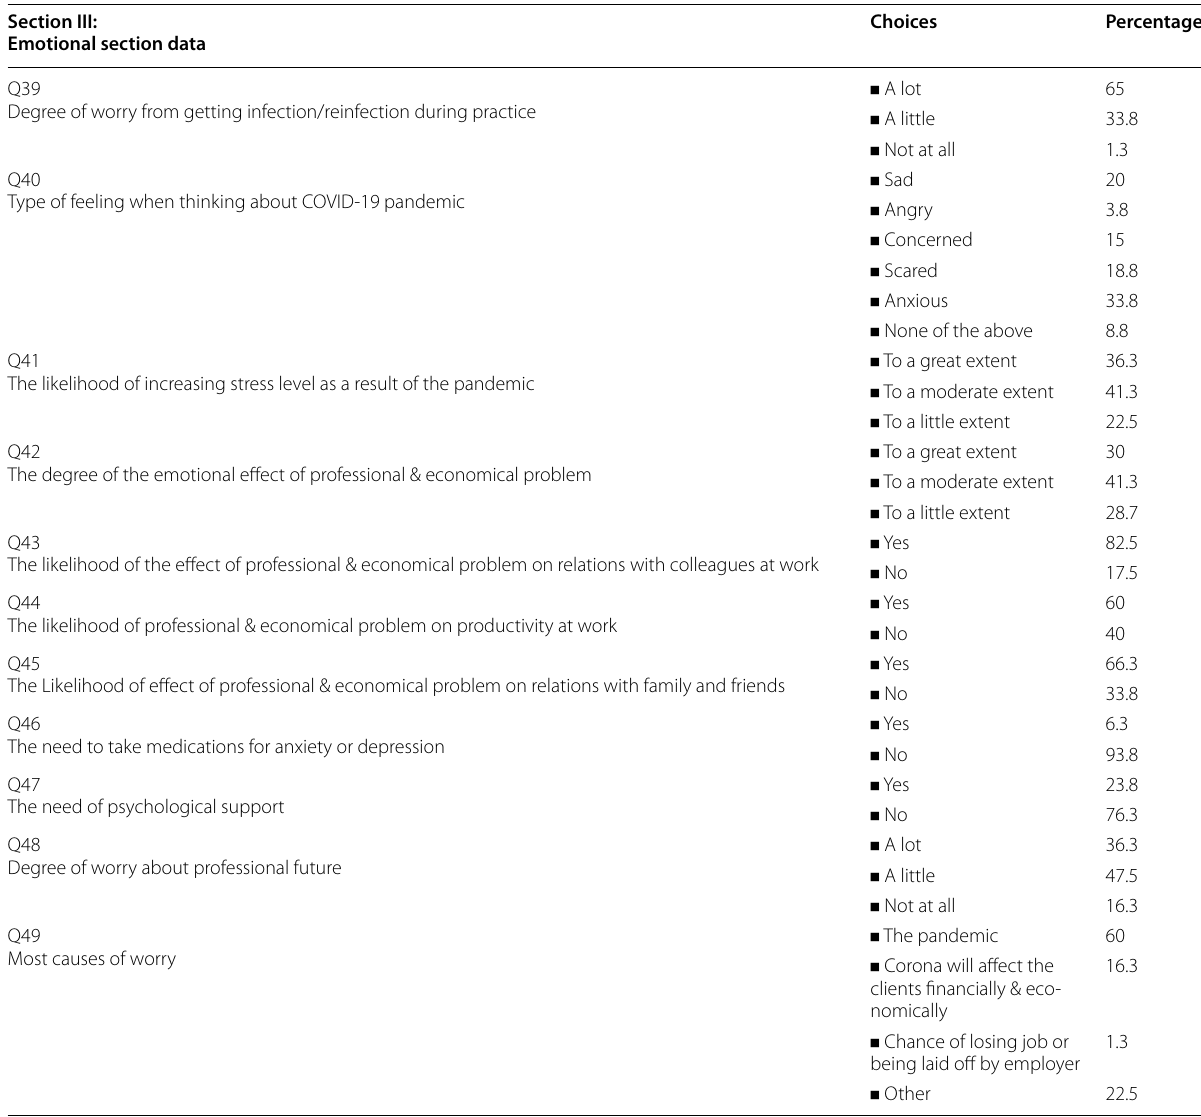
Table 3 The percentages of the collected data about the emotional aspect of the studied group of phoniatricians during the pandemic of